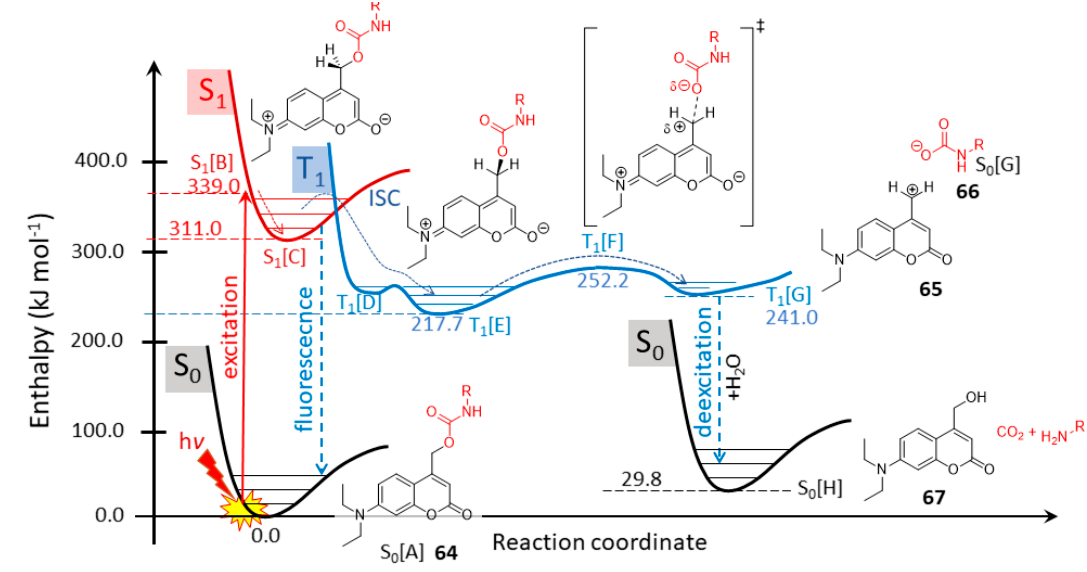
Figure 28. Reaction enthalpy ( H in kJ mol − 1 ) profile of the photochemical initiated scission of coumarin-caged model compound 63 to 65 + 66 , computed at B3LYP/6-31G(d,p)//PCM(water) level of theory.